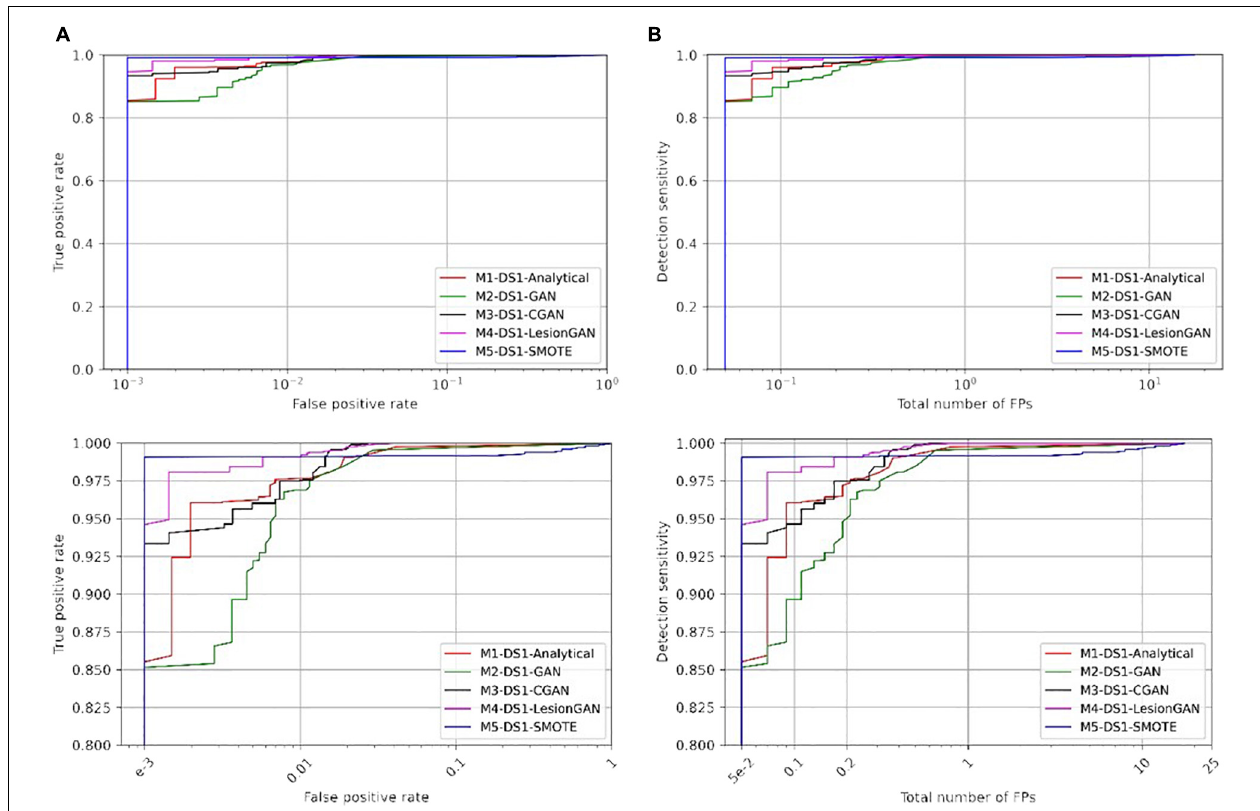
FIGURE 6 | Comparing receiver operating characteristic (ROC) (A) and free-response ROC (B) curves of five different training models for cerebral microbleed classification on the patch after training on 20,000 samples. The bottom panel shows the zoomed version.